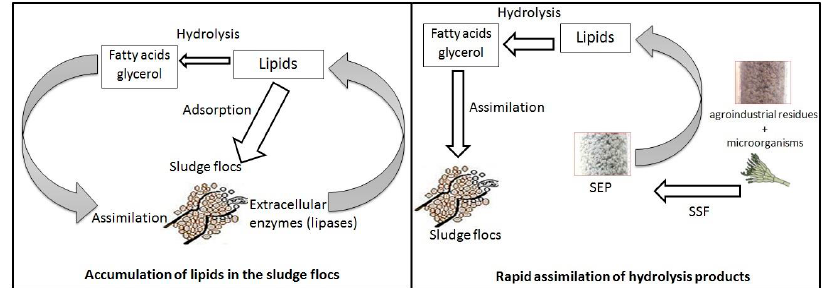
Figure 2. Steps of oil and grease (O&G) transformation in the conventional biological processes